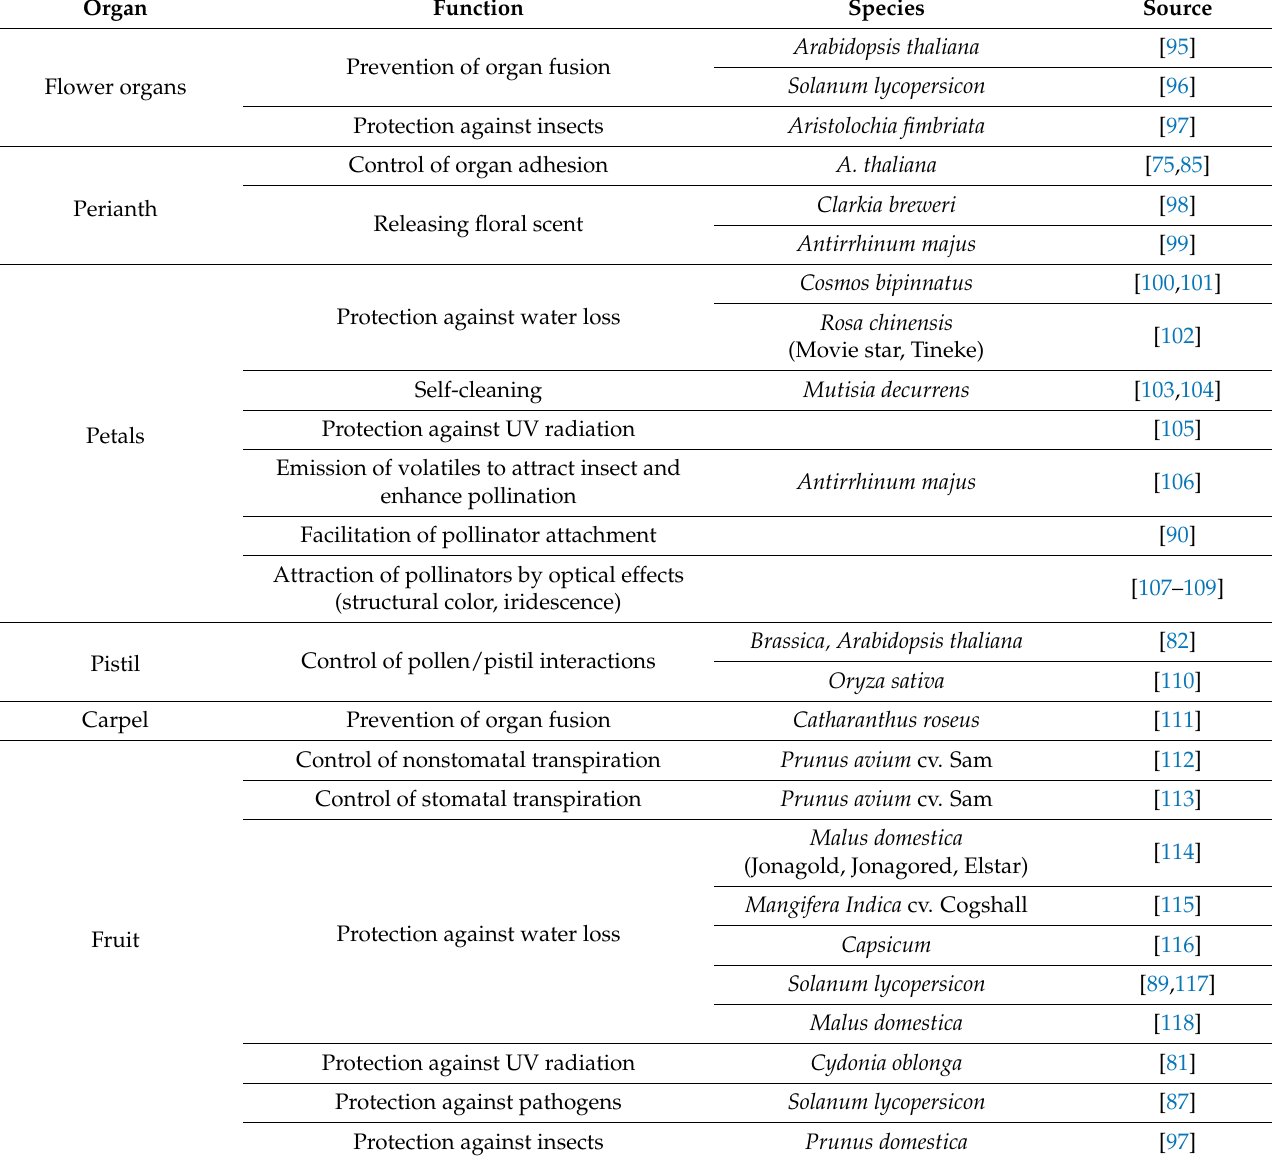
Table 1. Functions of cuticle in plant